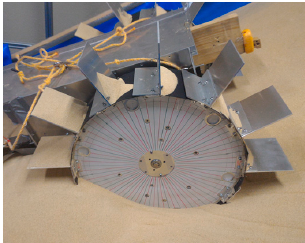
Figure 9. Measurement of the sinkage angle using the angle measurement scale lines. (Sinkage angle for the figure is 130 degrees).